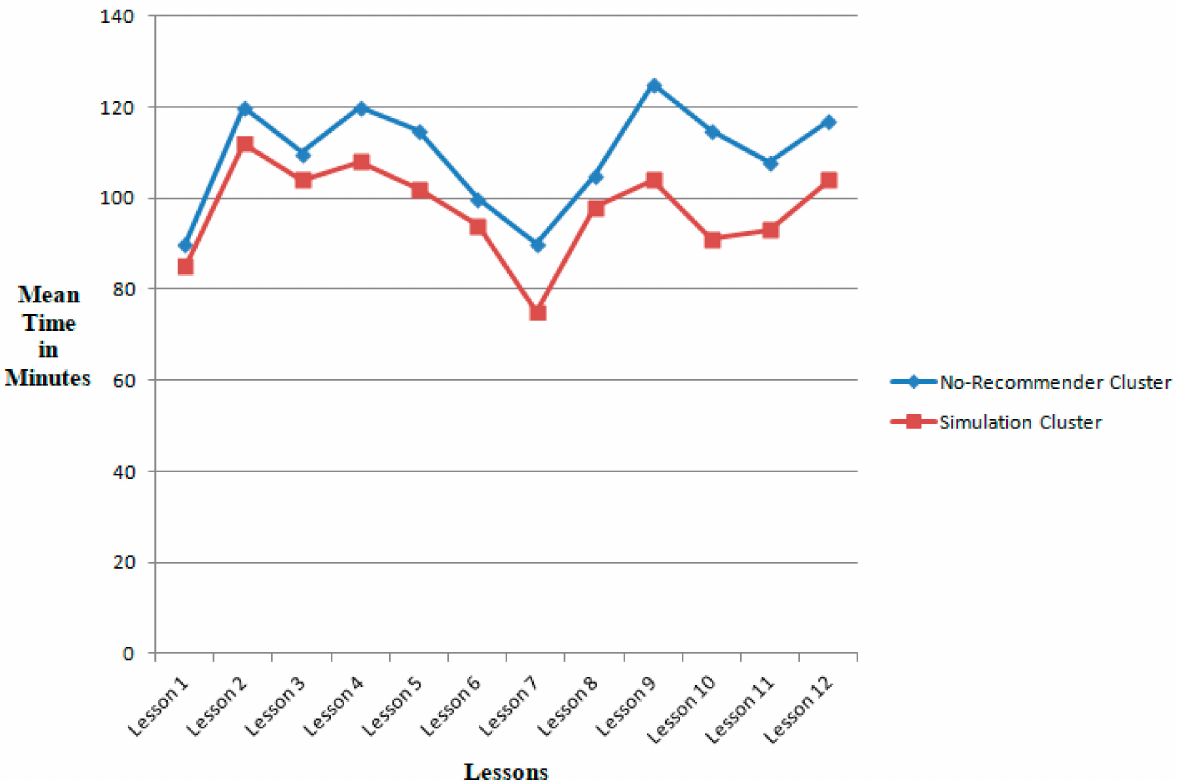
Figure 10. Mean computational time of no-recommender versus simulation clusters.